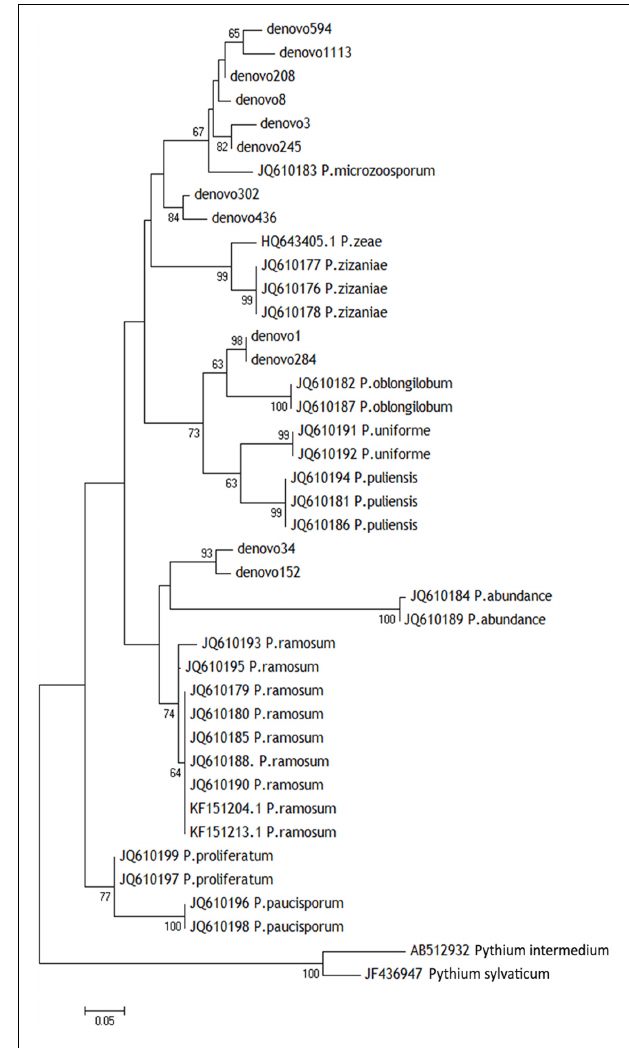
FIGURE 7 | Neighbor-joining phylogenetic tree based on ITS1 region showing the diversity of Pythiogeton species in our root, rhizosphere, and bulk soil samples. Sequences from this study are shown with denovo numbers, whereas reference sequences are listed with the NCBI accession numbers. The two most abundant Pythium species were used as outgroups. Numbers at branching points are bootstrap percentages based on 1000 replications. Only values > 50% are